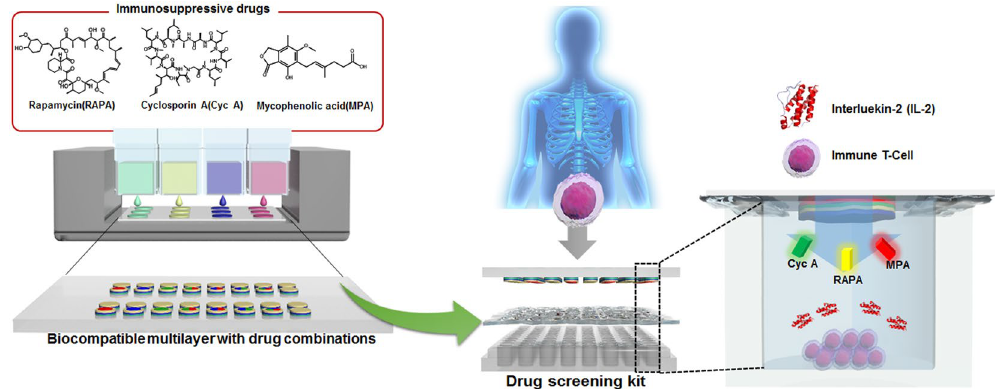
Figure 1. Schematic illustration of a three layered drug screening kit to effectively analyze various effects of medication for immunosuppression with inkjet printed biocompatible nanofilms including various drug combinations (The figure including inkjet printing image, Human torso image, the Immune T-Cell and the drug screen kit was drawn by